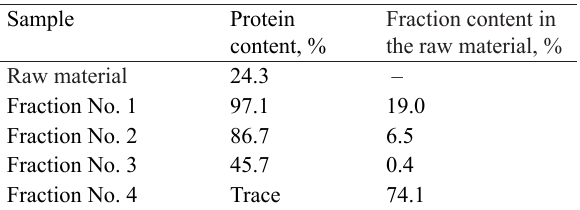
Table 1 Protein content in the initial raw material and in